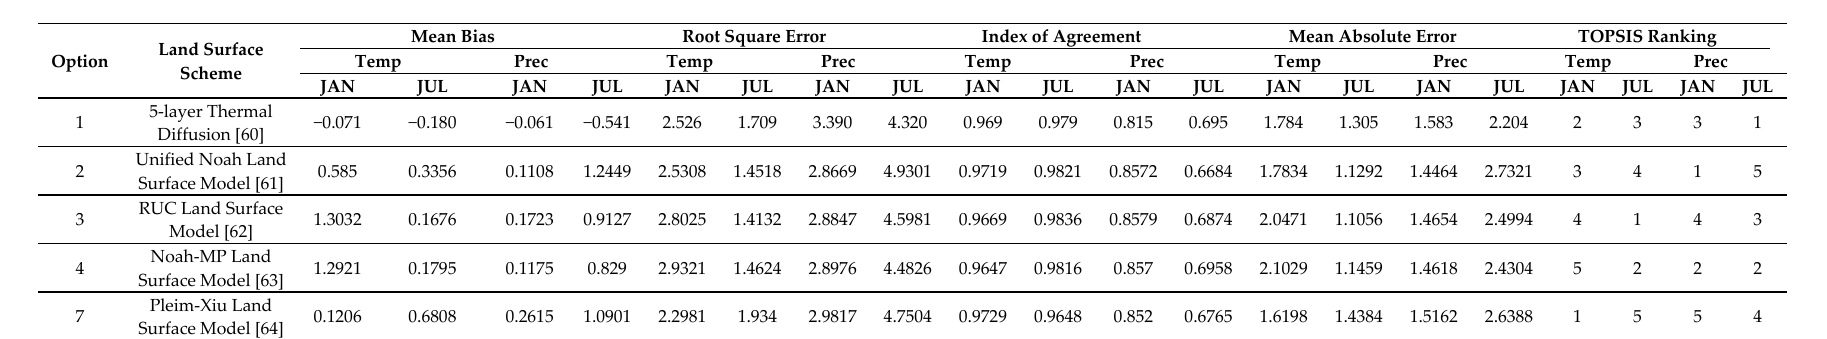
Table 7. Statistical measures and TOPSIS ranking for the Land Surface simulation